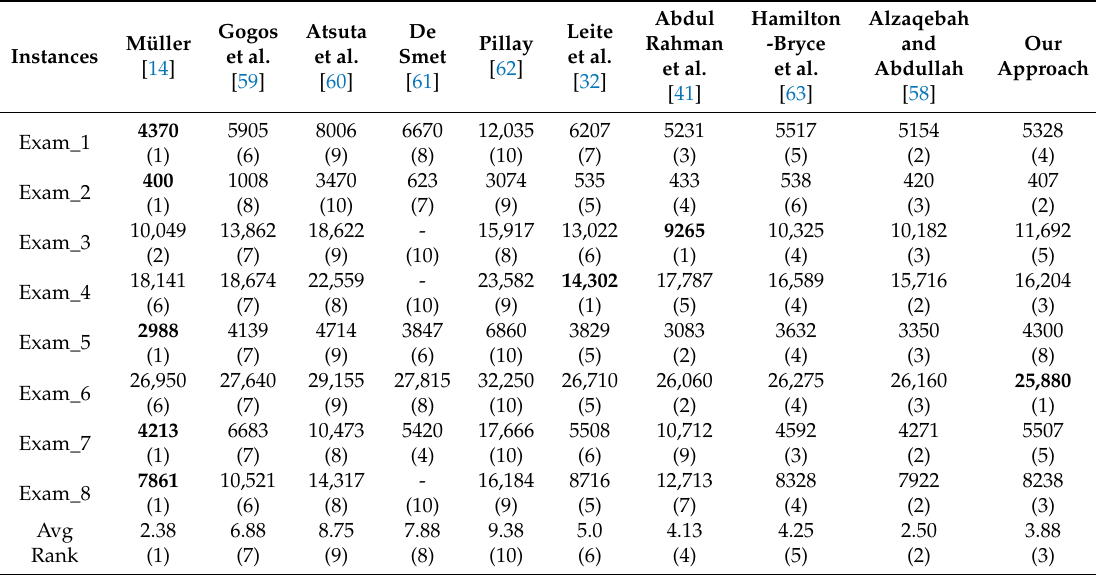
Table 9. Best results from our proposed approach (PGH-mGD) compared to the results from the scientific literature for the ITC2007 exam